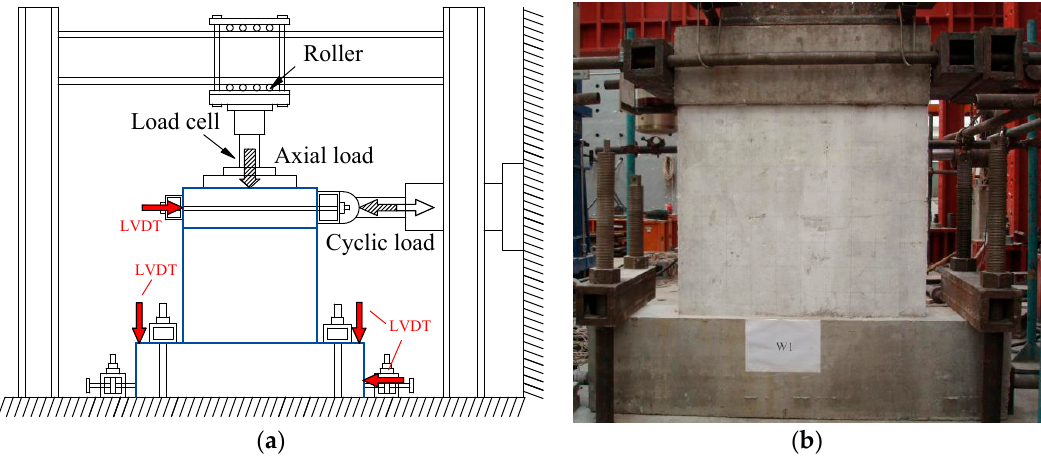
Figure 5. Test setup. ( a ) Loading scheme and measurements; ( b ) Photograph of loading.